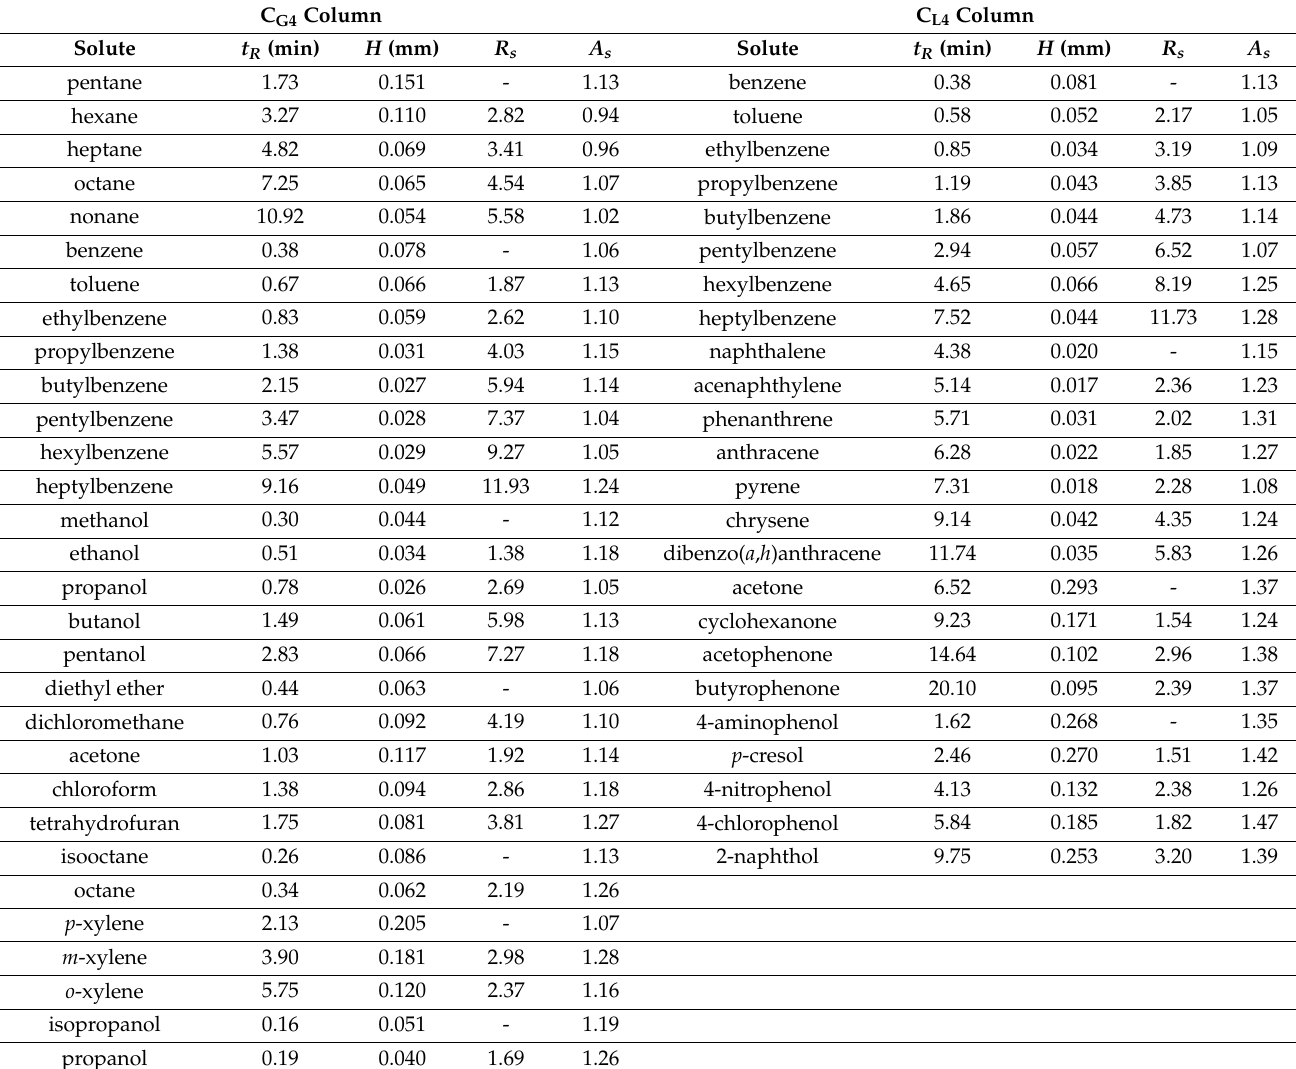
Table 2. Peak parameters for the separation of the studied mixtures using the C G4 and C L4 columns expressed in terms of t R , H , R s , and A s under the optimal